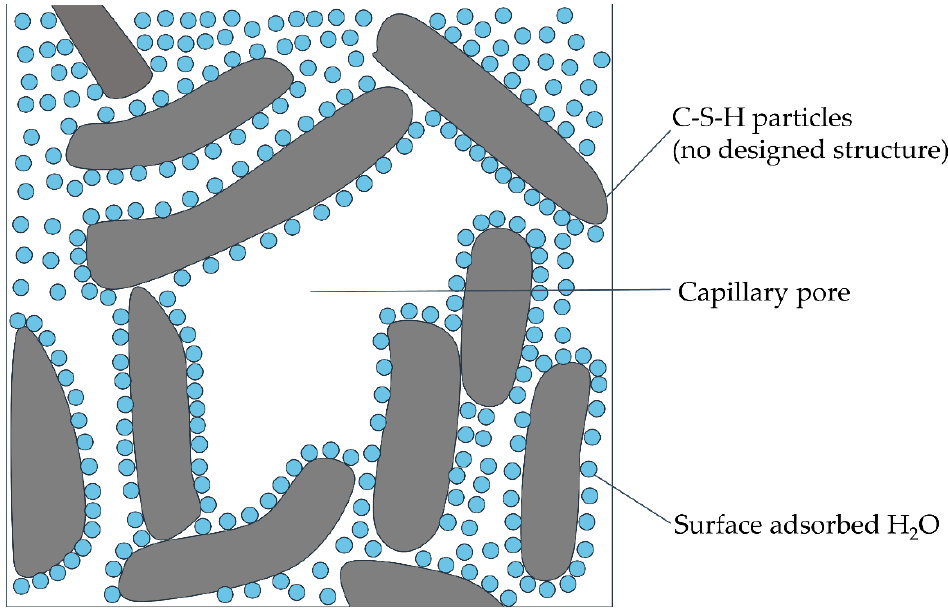
Figure 4. Munich model